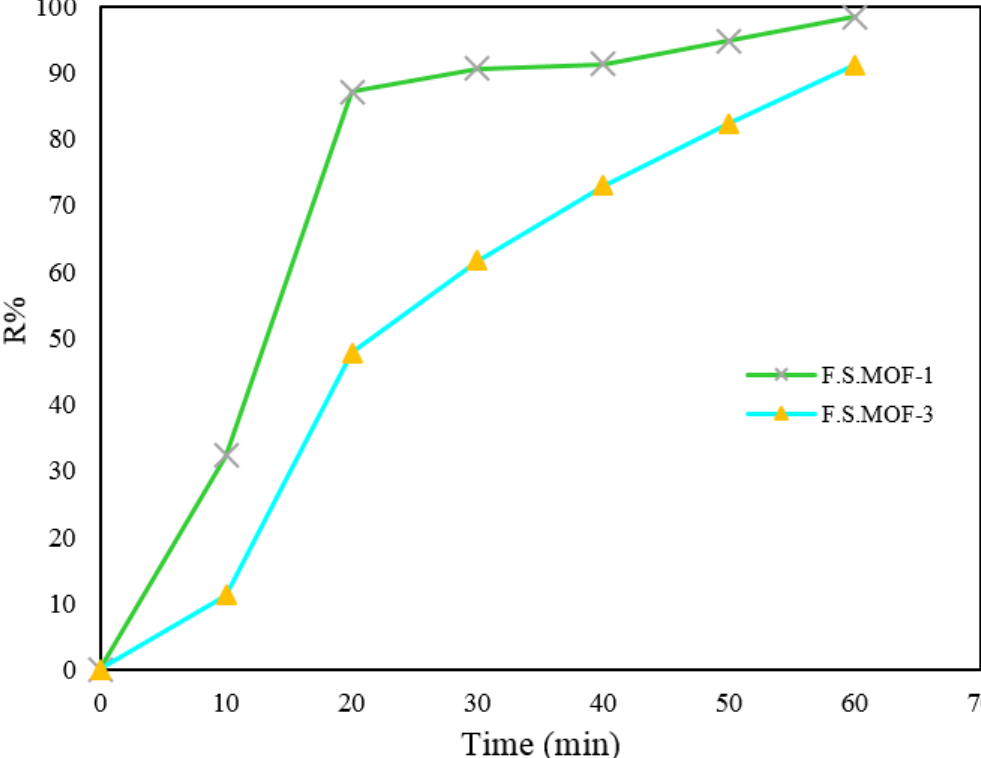
Fig. 16. Diagram of methylene blue dye removal using nanocomposites with different percentages of nickel ferrite in a silica substrate